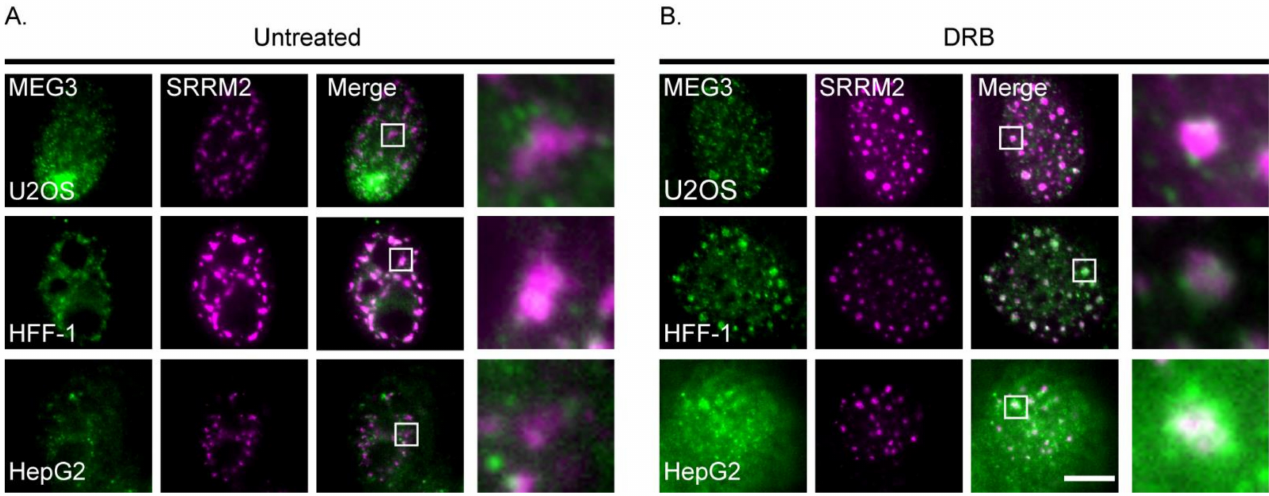
Figure 4. Endogenous MEG3 localizes to nuclear speckles. ( A ) RNA FISH of MEG3 transcripts (green) and antibody staining to SRRM2 (magenta) in (Top) untreated U2OS MEG3-MS2 cells; (Middle) HFF- 1s; and (Bottom) HepG2 cells. Enlargements of boxed areas are on the right. ( B ) Same as A with DRB treatment (2 h). Bar = 10 µ